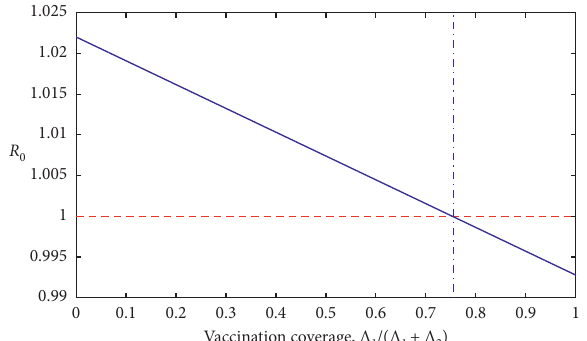
Figure 10: The relation between the rate of vaccination with R